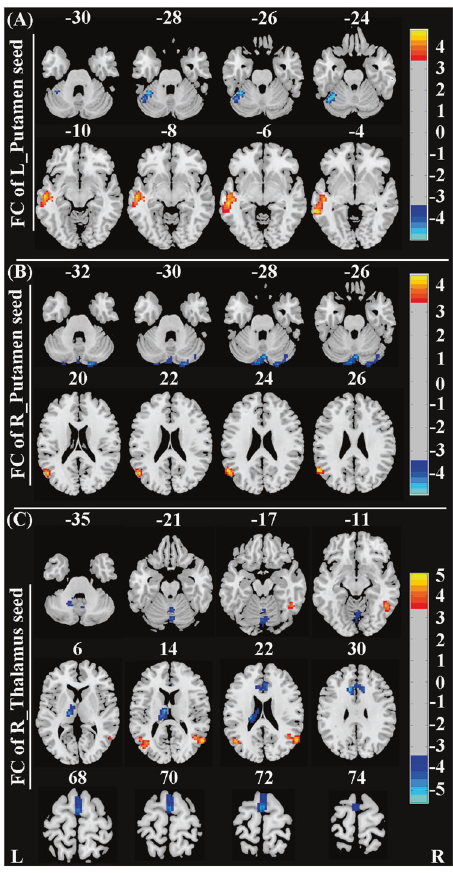
Fig. 2 Brain regions with signi fi cant differences in rs-FC between SAD patients and HCs (corrected with Gaussian random fi eld theory with a signi fi cance threshold of a voxel-wise value of P < 0.001 and cluster probability of P < 0.05). Warmer colors (positive values) represent increased rs-FC, while cooler colors (negative values) represent decreased rs-FC in SAD patients compared to HCs. Abbreviations: HCs, healthy controls; L, left; R, right; rs-FC, resting- state functional connectivity; SAD, social anxiety